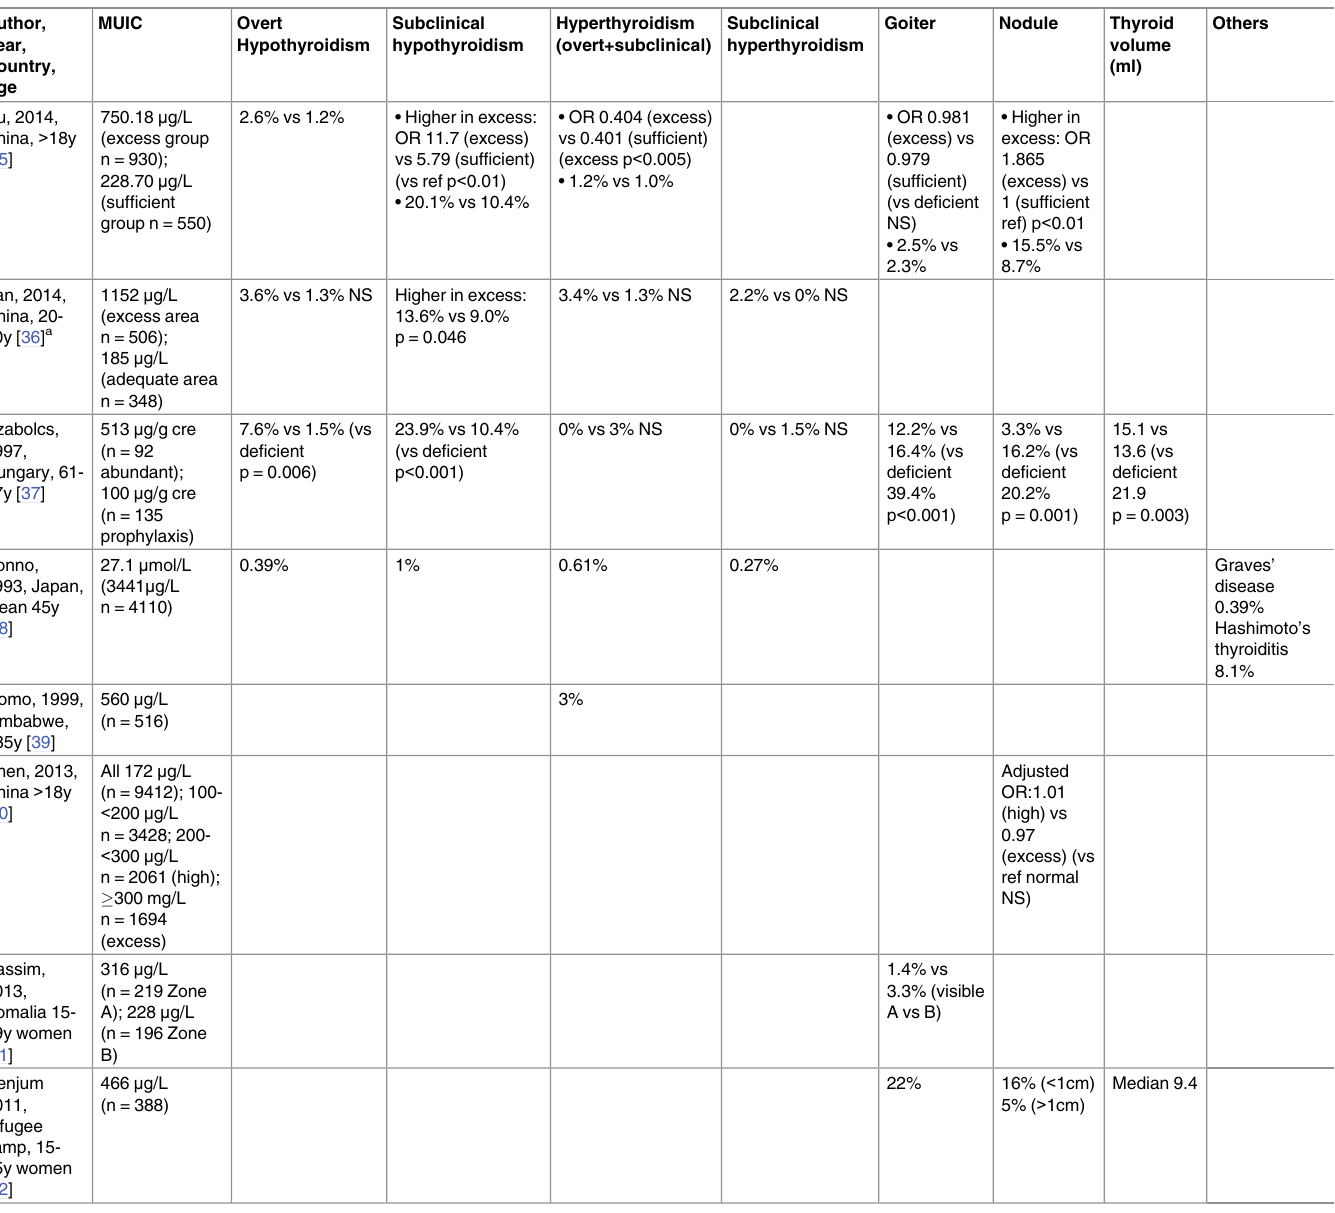
Table 4. Cross-sectional studies including excessmedian urinary iodine in